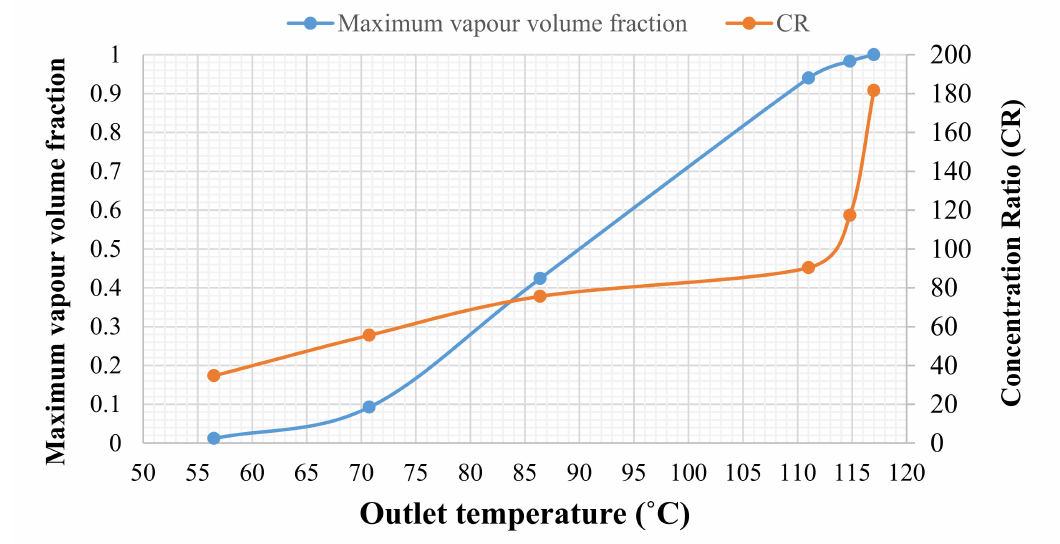
Figure 9. Evaluation of the obtained CR integers with respect to the maximum vapour volume fraction and outlet temperature to determine the optimal CR, for Zagazig.